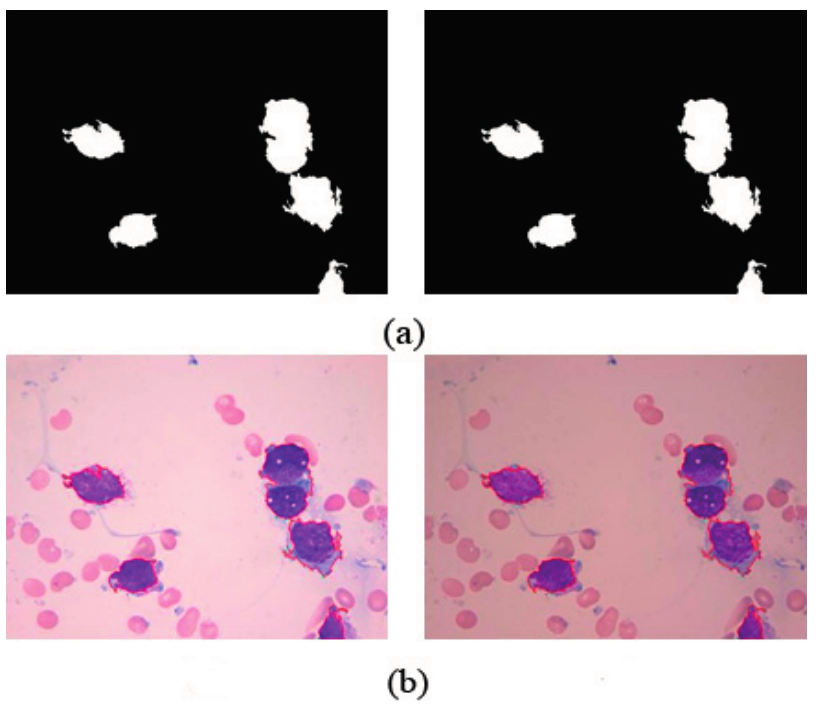
Figure 12. ( a ) Binary image of WBC segmentation in Figure 1a; ( b ) Segmentation results for Figure 1a under different light conditions (segmented WBCs marked with red